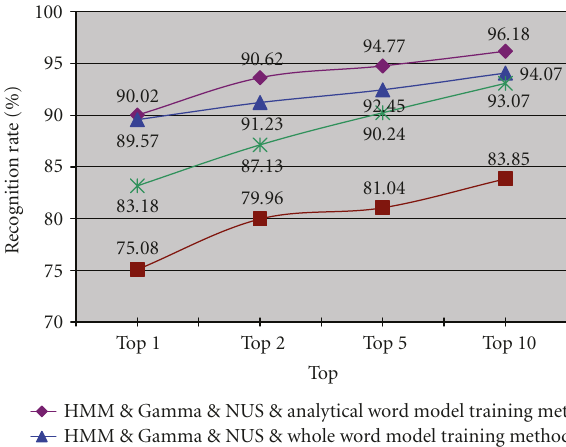
Figure 7: The best recognition performances of each training method which are obtained with the dataset c (6477 images) for test; NUS: nonuniform